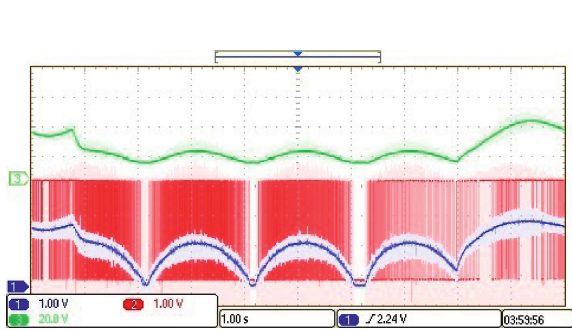
Figure 25: Output voltage (green), SSTA controller signal (blue), and ΣΔ M output (red) for trajectory